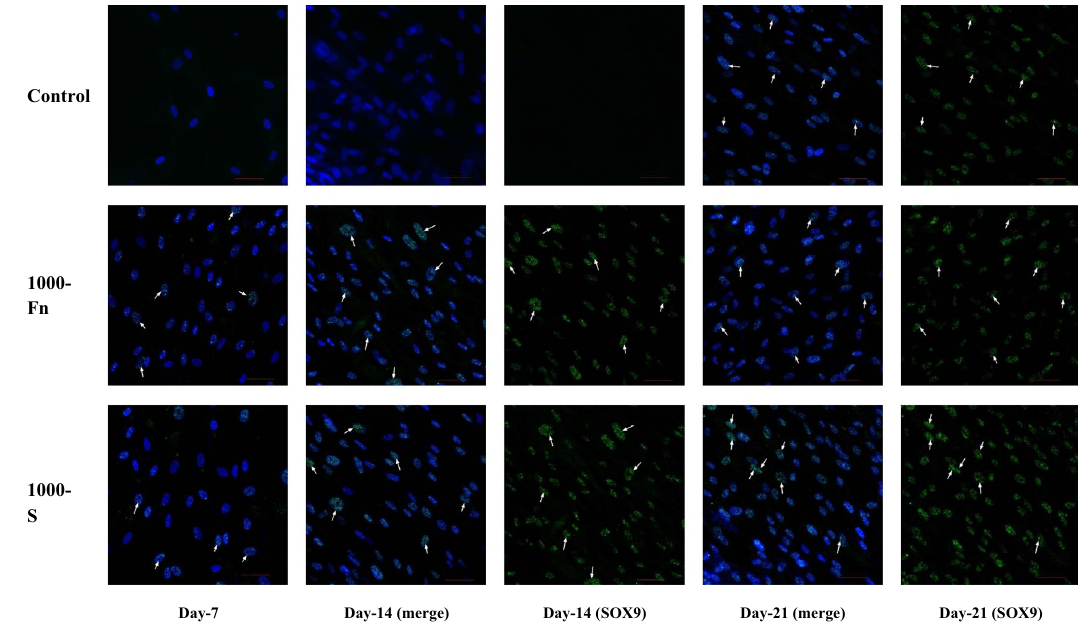
Figure 10. Immunocytochemistry (ICC) of SOX9 from hWJ-MSCs grown on spidroin and fibronectin micropattern after 7, 14 and 21 days of culture (Control = non-coated coverslip, 1000-Fn = 1000 µm